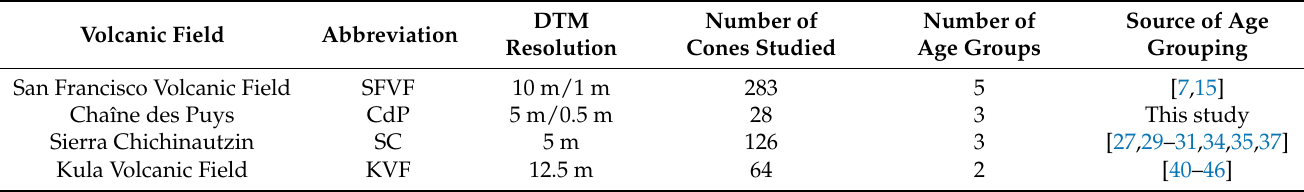
Table 1. Summary of the data of the studied volcanic